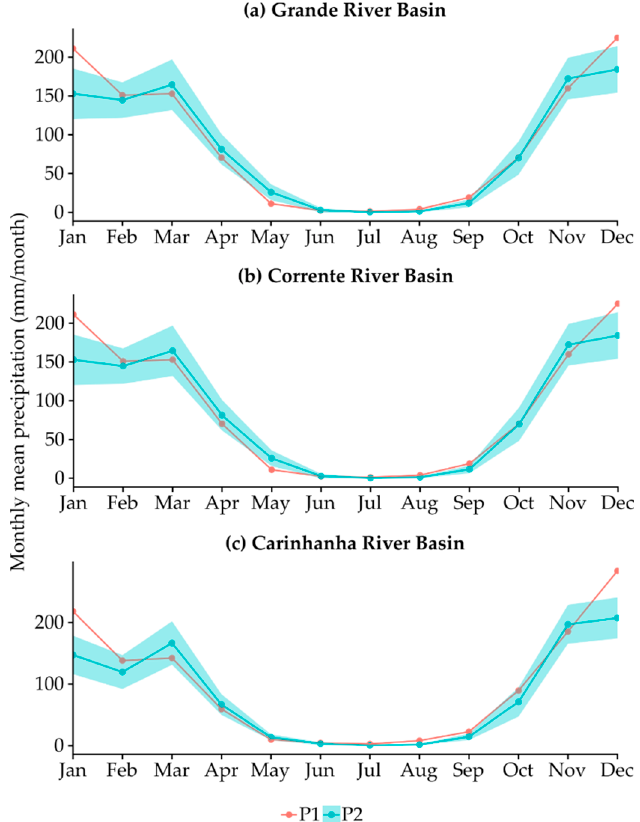
Figure 5. Monthly mean precipitation for two periods (P1 and P2) for the three basins. The shaded area in P2 is the confidence interval for the mean ( α = 0.05). Averages in P1 outside the shaded area are statistically di ff erent at this level of